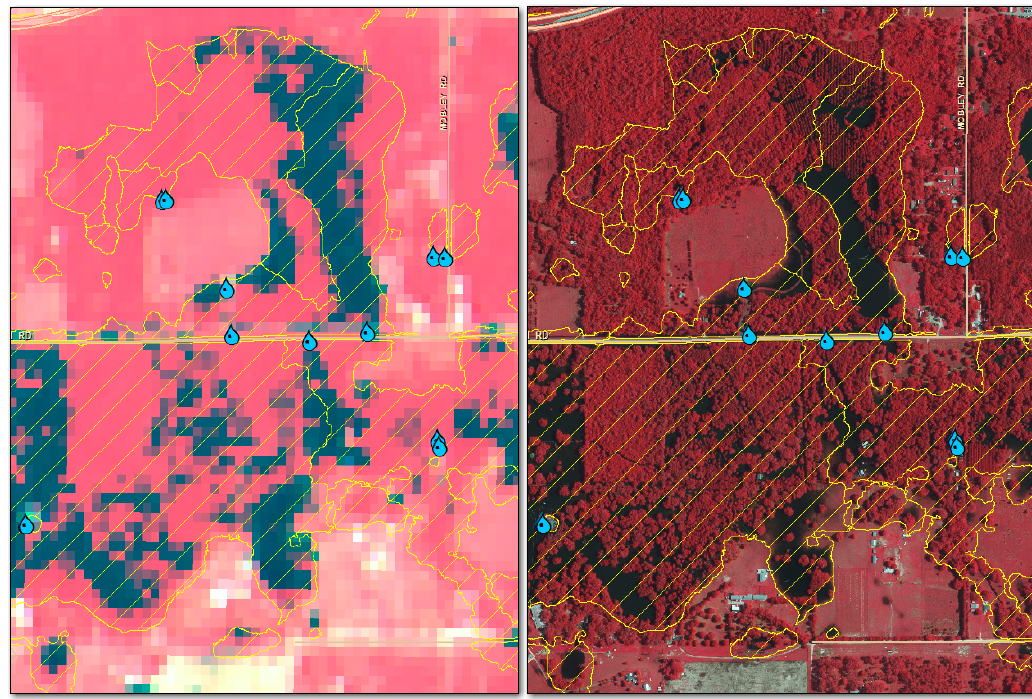
Figure 3. SPOT image ( left ) and fCIR image ( right ) with Tropical Storm Debby modeled floodplain polygons (yellow hatching). Field-measured high water marks are depicted by blue raindrops (scale ~ 1:12,500).